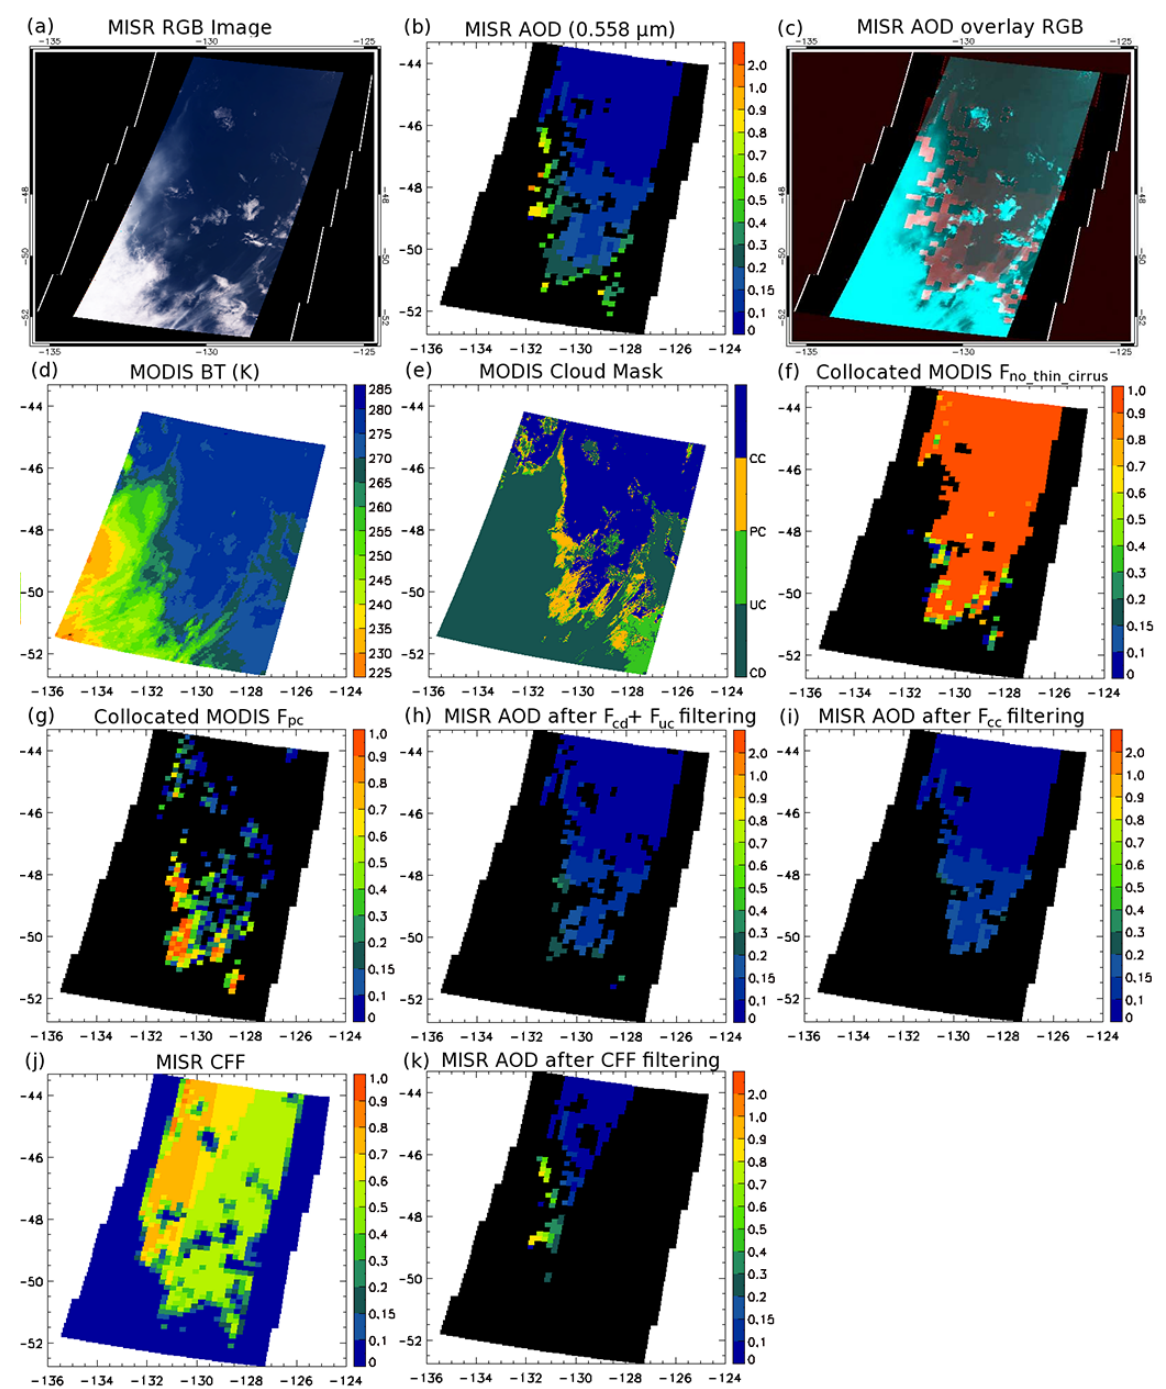
Figure 1. A case study on 3 January 2007, over the remote oceans (44 ◦ to 52 ◦ S and 124 ◦ to 136 ◦ W), (a) RGB image created using the MISR Near-IR, green and blue bands, (b) MISR self-QAed AOD over the case study region, (c) Overlay of (a) on (b) where the intensity of red is correlated with the magnitude of the AOD, (d) MODIS brightness temperature (BT), (e) MODIS cloud mask, (f) collocated MODIS thin cirrus-free cloud fraction ( F cirrus_free ) in MISR AOD domain, (g) similar to (f) but for the collocated MODIS probably clear fraction ( F pc ) , (h) MISR AOD after passing the MODIS cloudy fraction ( F cd )< 10% and the MODIS uncertainty clear fraction ( F uc )< 20% cloud filters, (i) MISR AOD after passing the MODIS confident clear fraction ( F cc )> 20% cloud filter, (j) MISR clear flag fraction (CFF), and (k) MISR AOD after passing the MISR CFF > 60%